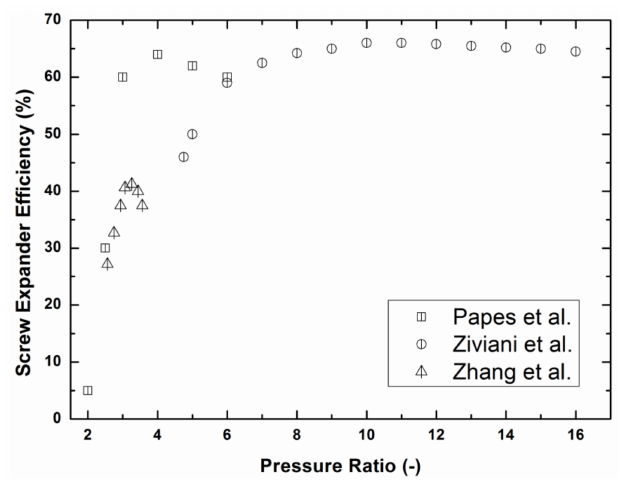
Figure 6. Performance of screw